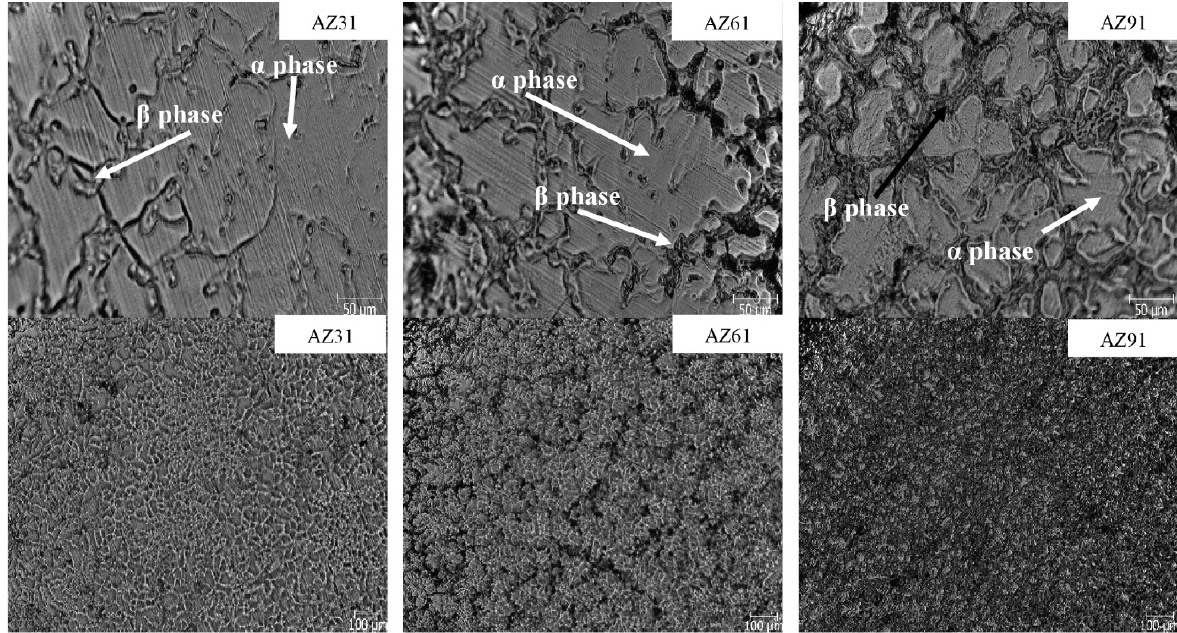
Figure 7: Microstructure images of AZ31, AZ61 and AZ91 Mg alloy